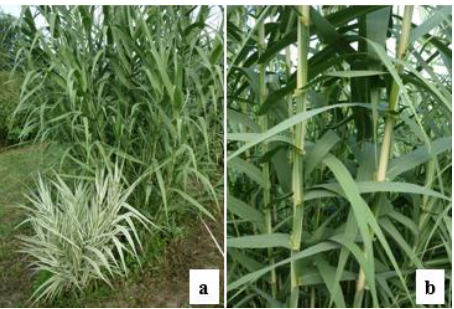
Figure 4 . 3-year-old leaf variants of striped giant reed derived from somatic embryogenesis (Debrecen, Hungary – July 2015) Source: photos by Gabriella